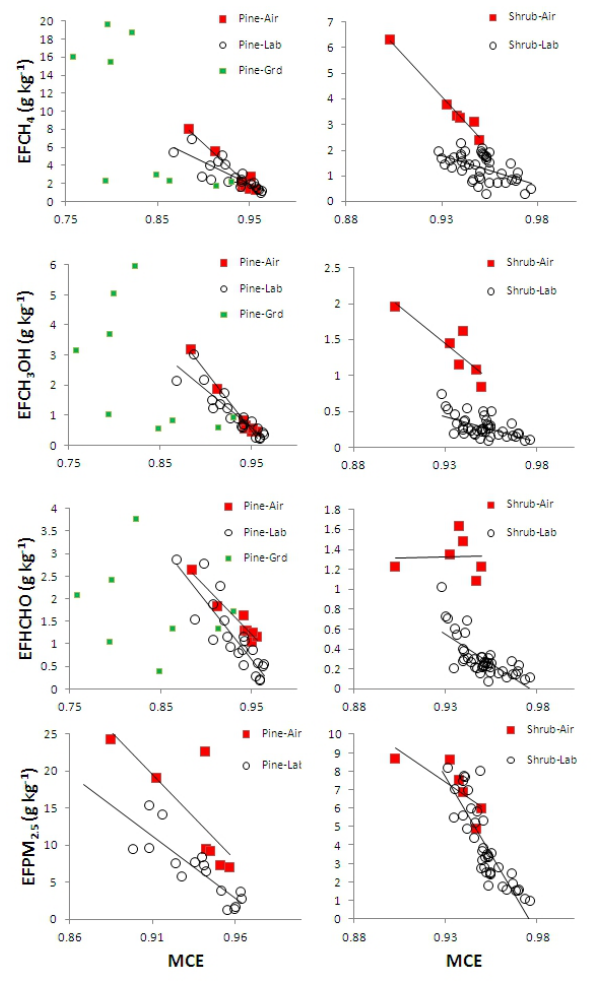
Fig. 2. Comparison of EF versus MCE from the lab and the field fires for smoldering compounds and PM 2 . 5 for pine understory (left column) and semiarid shrubland (right column). The “Grd” (green symbols) indicate data for residual smoldering combustion provided for context (see